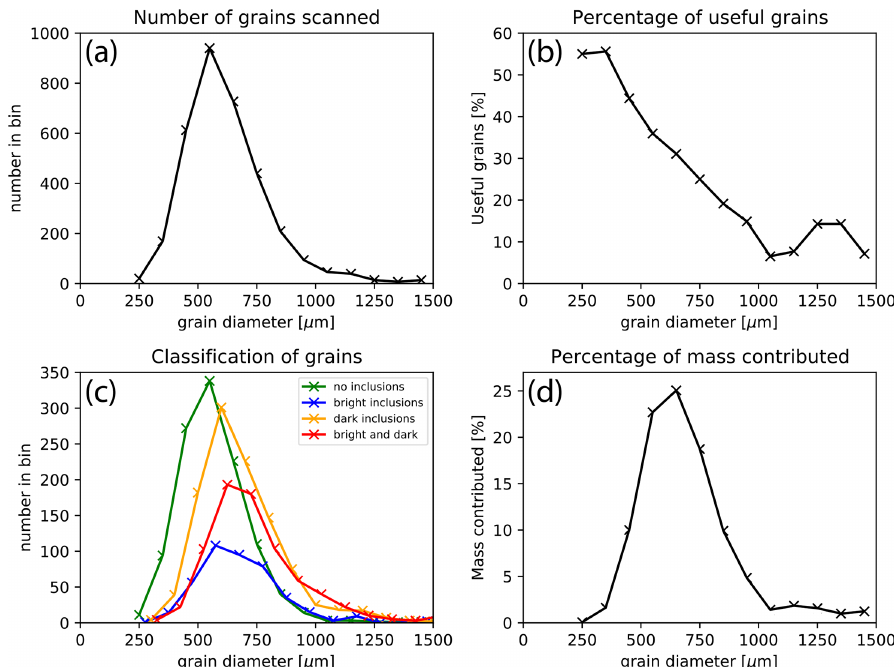
Figure 5. Results of the classification of grains according to inclusions identified by microCT imaging, showing that the most useful (inclusion-free) grain size range for analysis was 400–800µm. All plots are histograms with grain size bins of 100µm width. (a) The total number of grains that were scanned, presented by grain size. (b) The percentage of grains for each grain size bin that was found to be suitable (i.e., without inclusions). (c) Classification of grains into those with no inclusions, bright inclusions, dark inclusions, and bright and dark inclusions. (d) The percentage of the total mass of grains used for analysis in each grain size bin. Mass was estimated based on the grain diameter and the mean density of